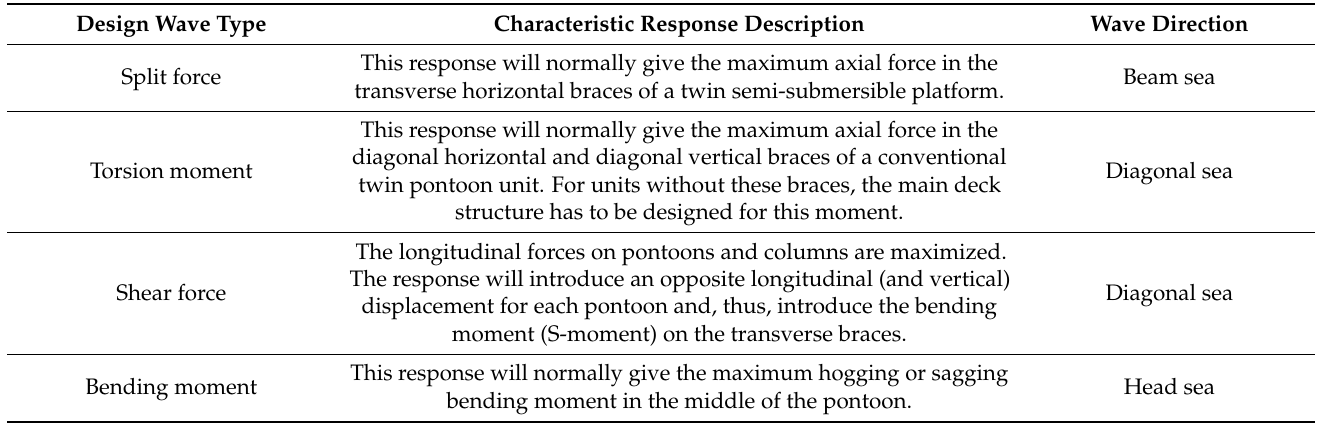
Table 2. Theoretical response description for typical design wave.